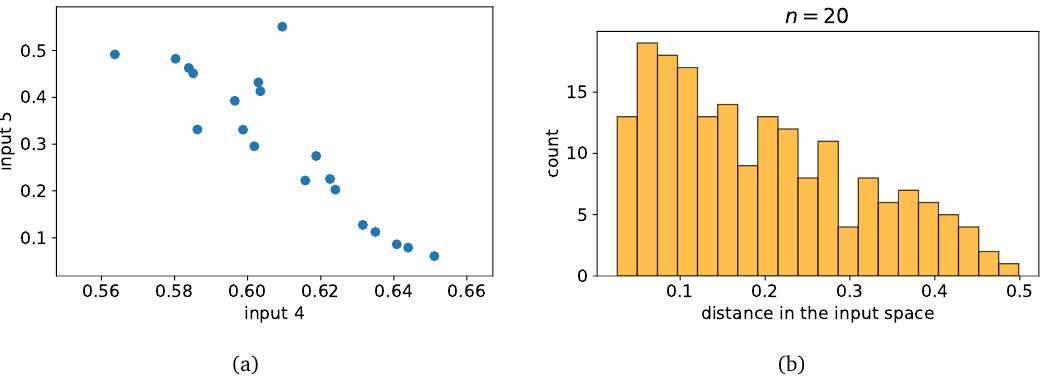
Figure 9: Input space points that map into the hypercube with the largest R -value in the main sample, R = 54. (a) Oblong shape of the distribution is responsible for the large R value. (b) Pairwise distances among the input-space points show no evidence for a bimodal